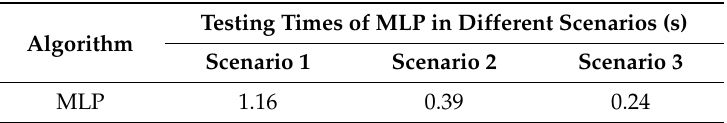
Table 5. Regression-based computational